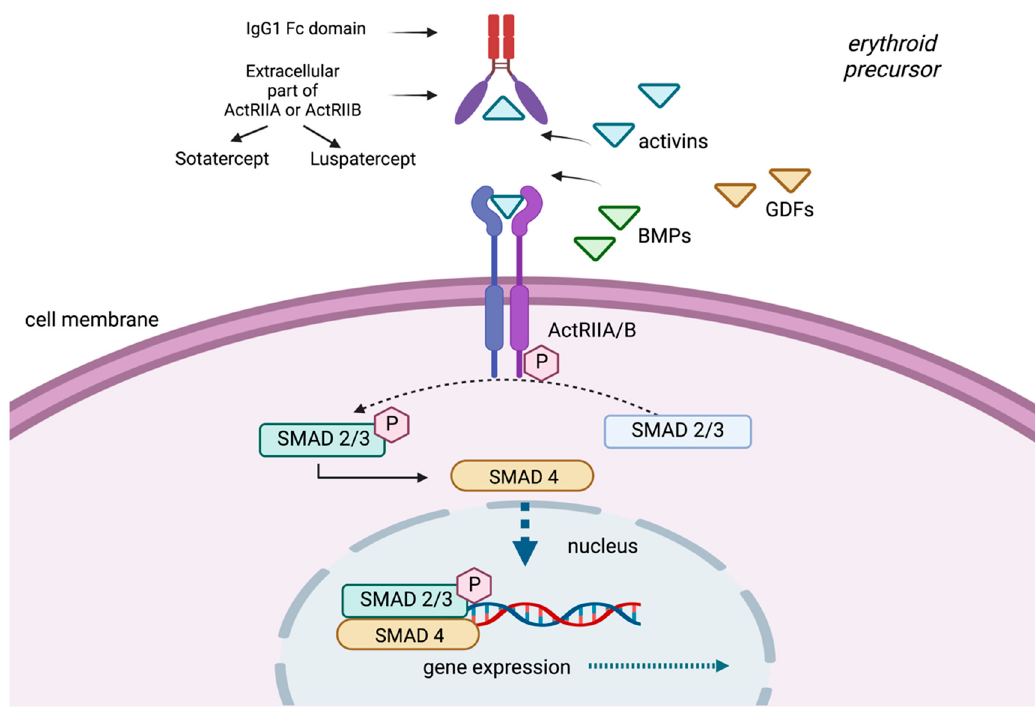
Figure 2. The TGF- β signaling pathway and its ligand